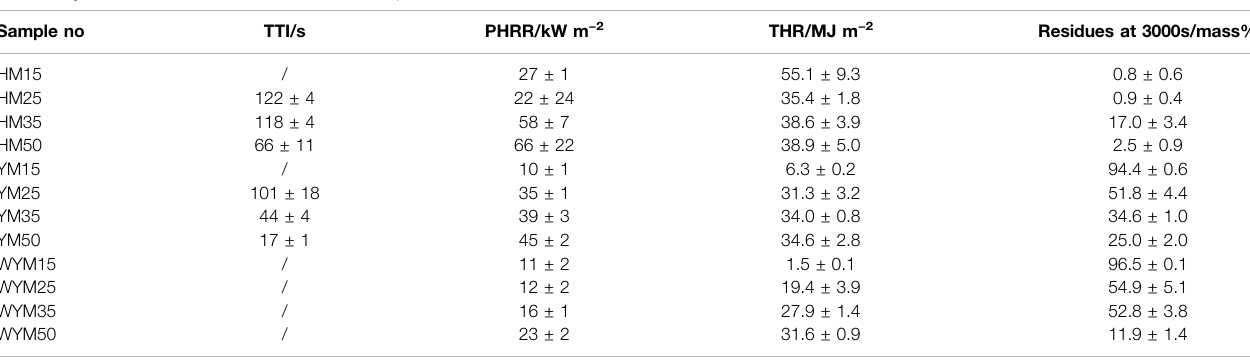
TABLE 3 | The related heat release data of coal samples.